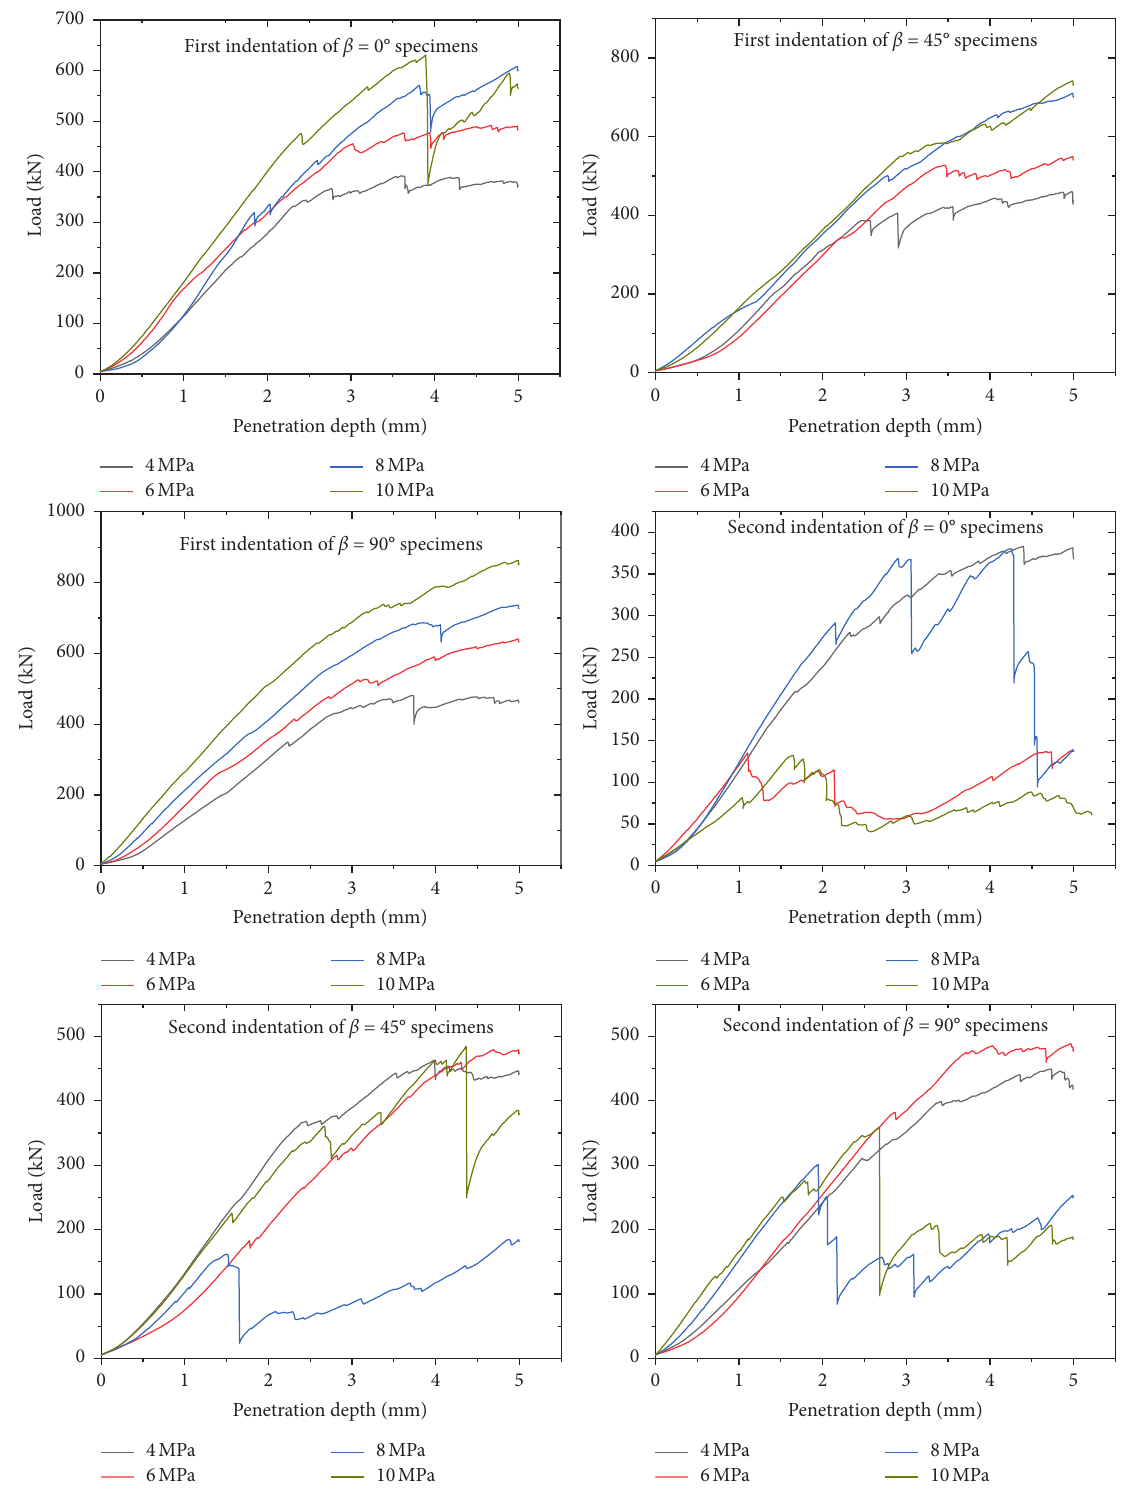
Figure 5: The first and second typical load-penetration depth